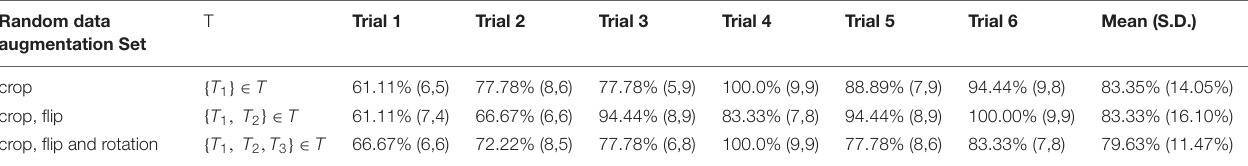
TABLE 2A | Classification accuracy for the test sets per trial, for all three data augmentation strategies. Random data augmentation